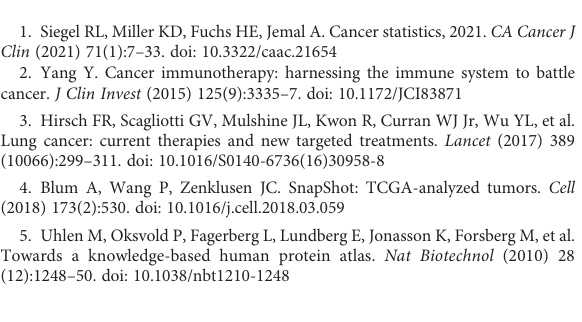
SUPPLEMENTARY FIGURE 5 Associations of the RCSD1 expression level with lymphocytes, immunomodulators and chemokines in LUSC. (A) Correlations between abundance of tumor-in fi ltrating lymphocytes (TILs) and RCSD1 (plus the six TILs with the highest correlation). (B – D) Correlations between immunomodulators and RCSD1 (plus the six immunomodulators with the highest correlation, respectively). (E, F) Correlations between chemokines (or receptors) and RCSD1 [plus the six chemokines (or receptors) with the highest correlation, respectively]. SUPPLEMENTARY TABLE 1 The relationship between RCSD1 and lymphocytes. SUPPLEMENTARY TABLE 2 The relationship between RCSD1 and Immunoinhibitors. SUPPLEMENTARY TABLE 3 The relationship between RCSD1 and immunostimulators. SUPPLEMENTARY TABLE 4 The relationship between RCSD1 and MHC molecules. SUPPLEMENTARY TABLE 5 The relationship between RCSD1 and chemokines. SUPPLEMENTARY TABLE 6 The relationship between RCSD1 and